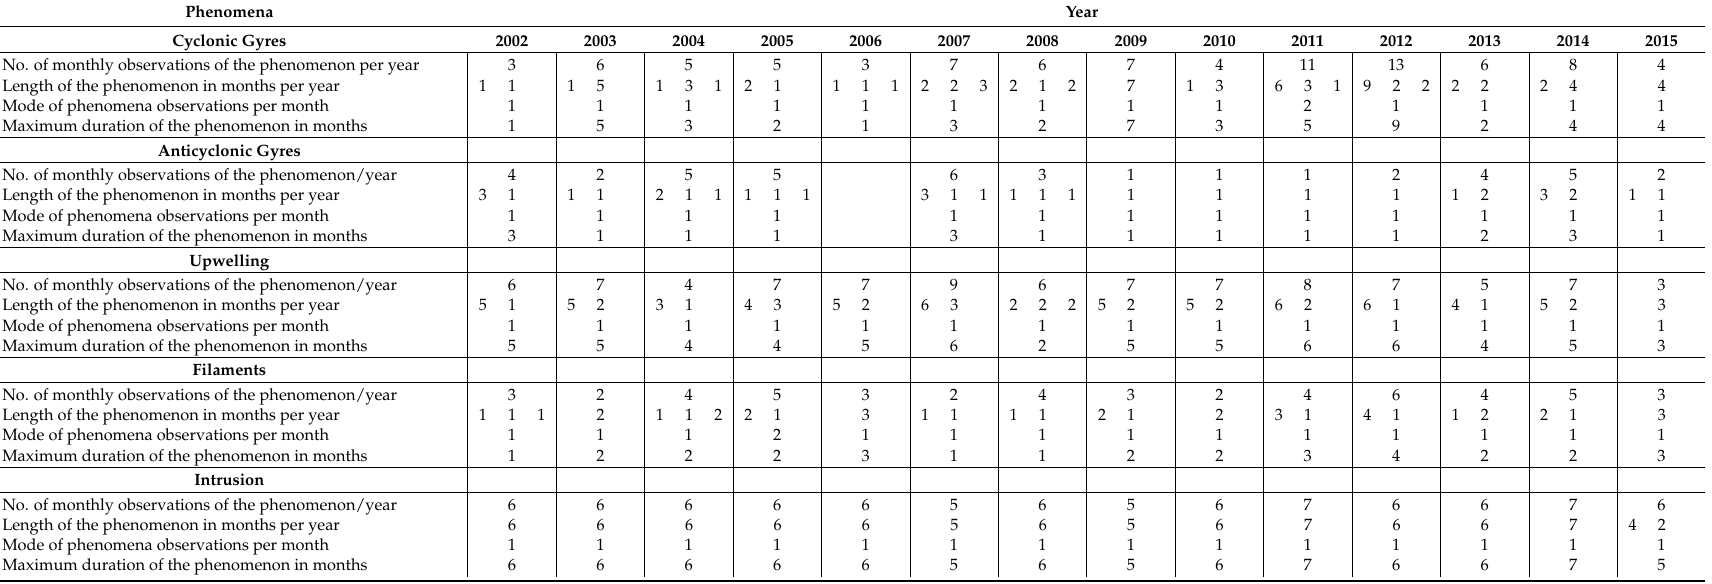
Table 1. The number of monthly observations of phenomena per year, length in months of phenomenon per year, its mode of observation per month and its maximum length in the central and southern coastal region of Sonora and adjacent deep zone in the Gulf of California, Mexico, from